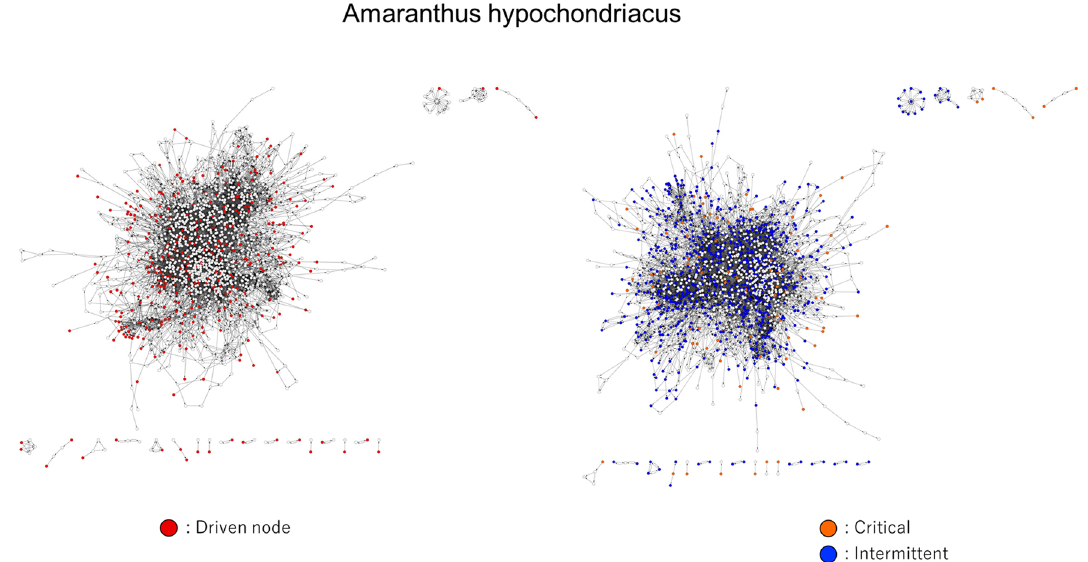
Figure 7. Network visualization of the Aramanthus hypochondriacus plant, commonly known as prince’s feather, that belongs to the eudicot plant lineage. Left: Identified driven enzymes are denoted in red. Right: Identified critical, intermittent, and redundant driven enzymes are denoted in orange, blue and white,